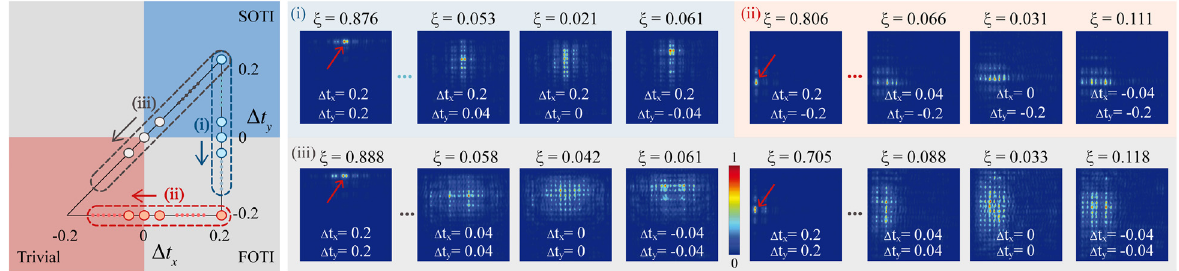
Figure 4: Experimental observation of creation and destruction of topological edge states. There are three detected trajectories for observing the creation and destruction of topological edge states under the modulation of Δ t FOTI to trivial phases and from SOTI to trivial phases is marked by blue, red and gray dash lines, respectively. The red arrows indicate the launching